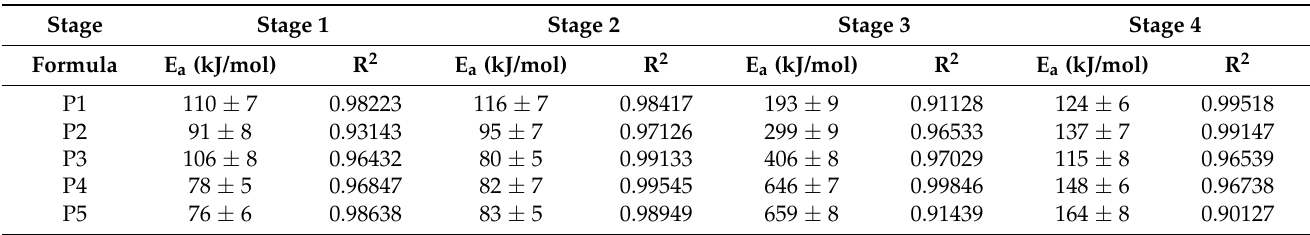
Table 7. Reaction kinetic parameters of Samples P1–P5 at each stage of pyrolysis calculated via Starink’s